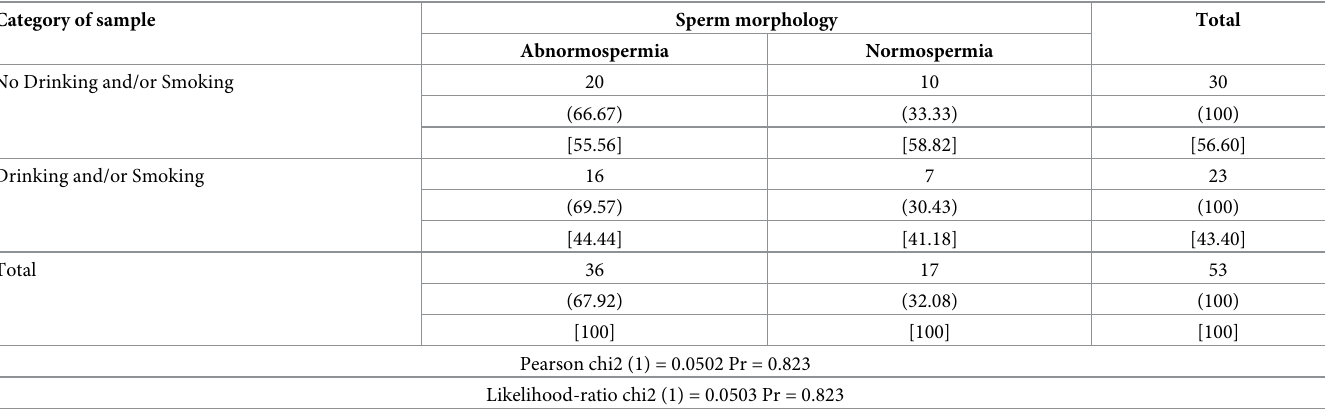
Table 3. Sperm morphology and lifestyle (smoking and/or drinking).